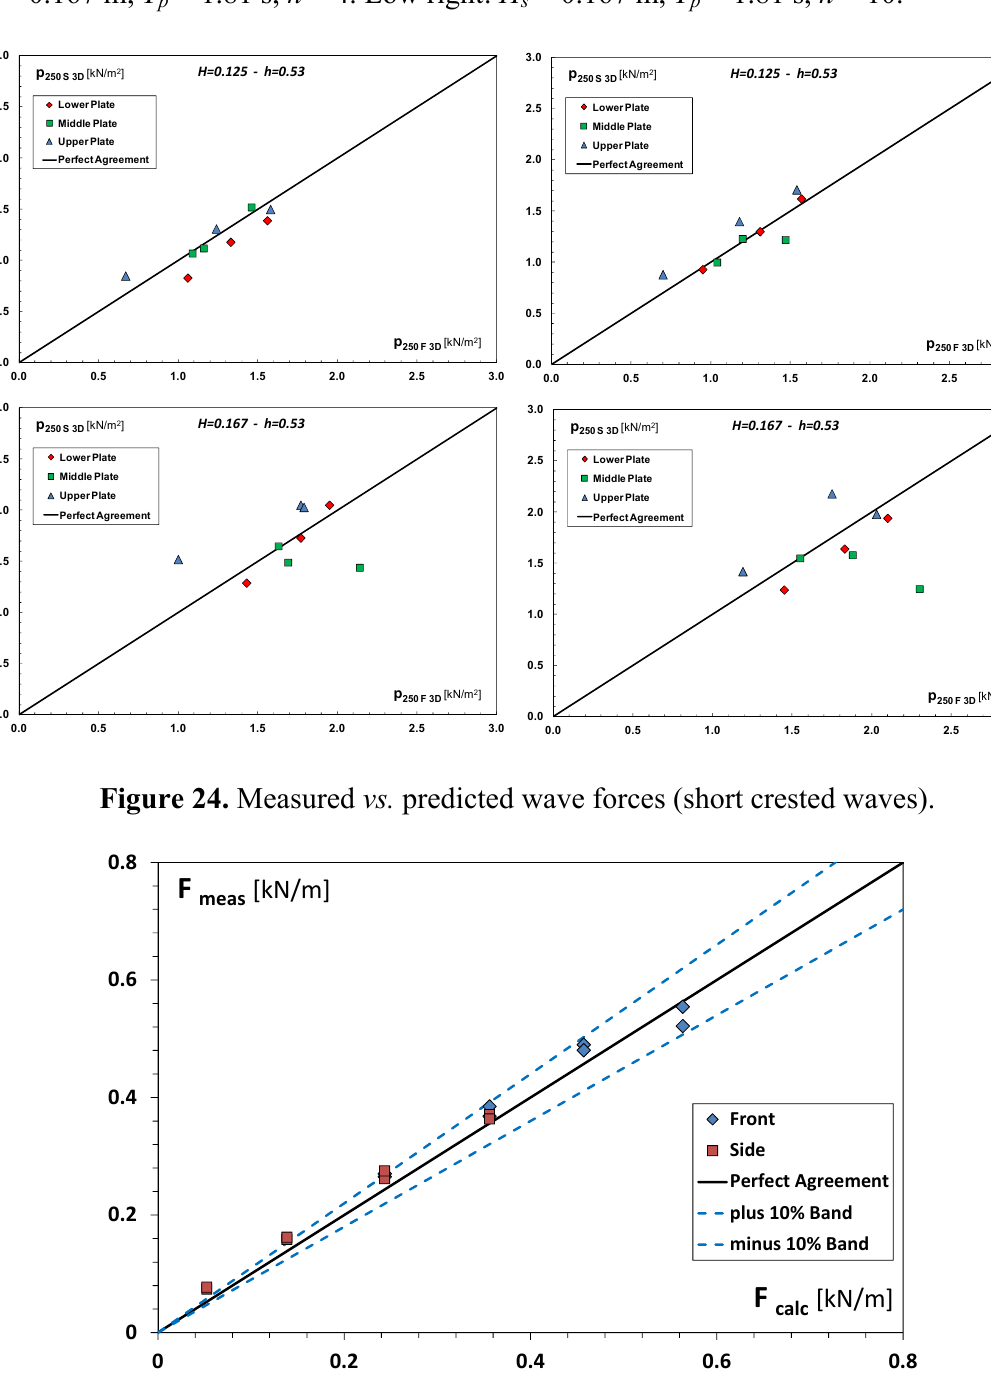
Figure 23. Effect of the mean wave direction on short crested waves. Top left: H = 0.125 m, T = 1.55 s, n = 4. Top right: H s p H = 0.167 m, T = 1.81 s, n = 4. Low right: H s p